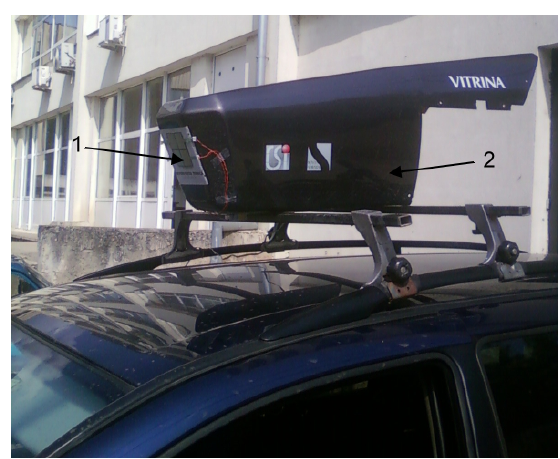
Figure 5. Experiment on body car nose aerodynamic characteristics (1-sensors measurement area, 2-body-car nose).